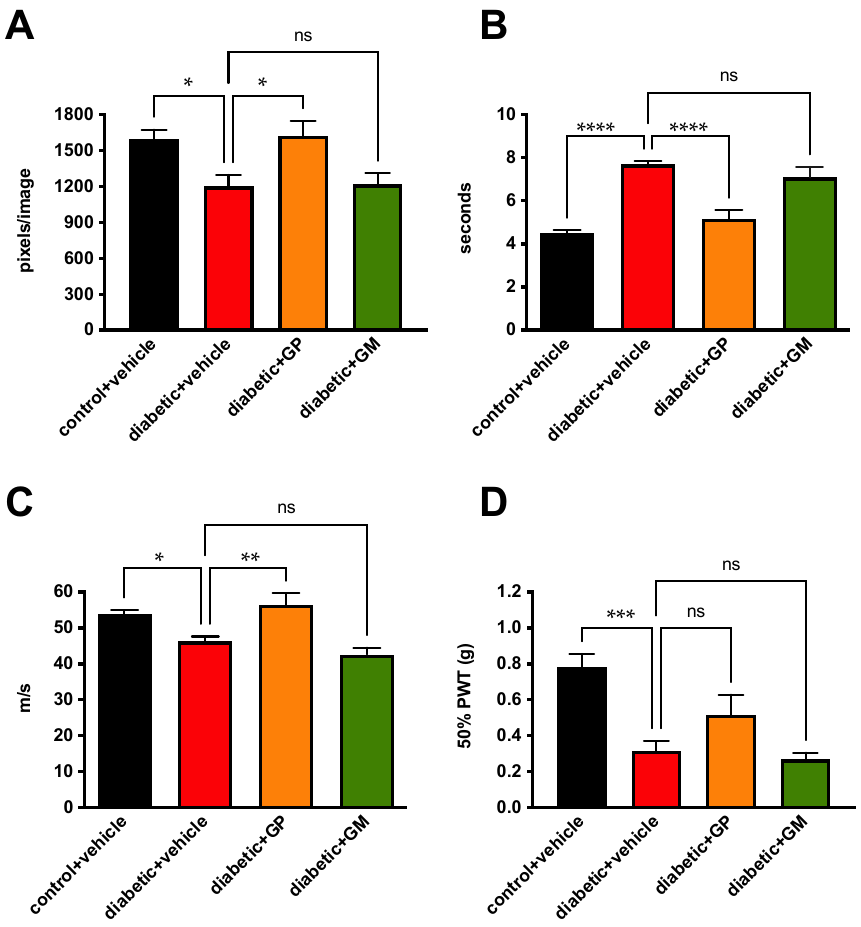
Figure 3. Prevention of neuropathy by systemic glycopyrrolate in diabetic mice. Sub-basal nerve plexus density ( A ), paw response latency to heat ( B ), sciatic motor nerve conduction velocity ( C ), and paw 50% response threshold to von Frey filaments ( D ) after 12 weeks of diabetes, with daily treatment to the eye with vehicle, glycopyrrolate (GP), or gallamine (GM). Data points are group mean ± SEM with between group analysis by one way ANOVA followed by Dunnett’s post hoc test. * = p < 0.05, ** = p < 0.01, *** = p < 0.001 and **** = p < 0.0001 vs. vehicle-treated diabetic mice. ns: not significant Table 2. Summary of treatments and their efficacy against indices of neuropathy in diabetic mice. ND = not determined.